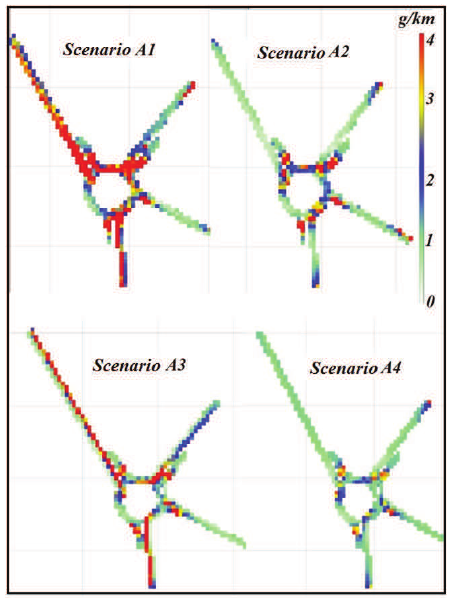
Fig. 9. NO x emission results for considered scenarios with spatial resolu- tion of 5x5 m